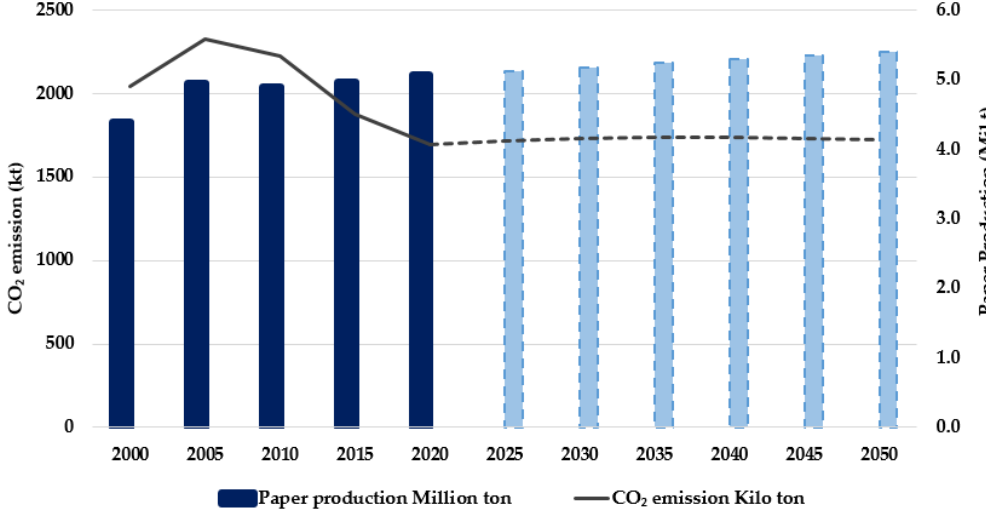
Figure 8. Projection of CO 2 emissions in the BAU (business as usual) scenario and paper production trend of the Austrian P&P sector.